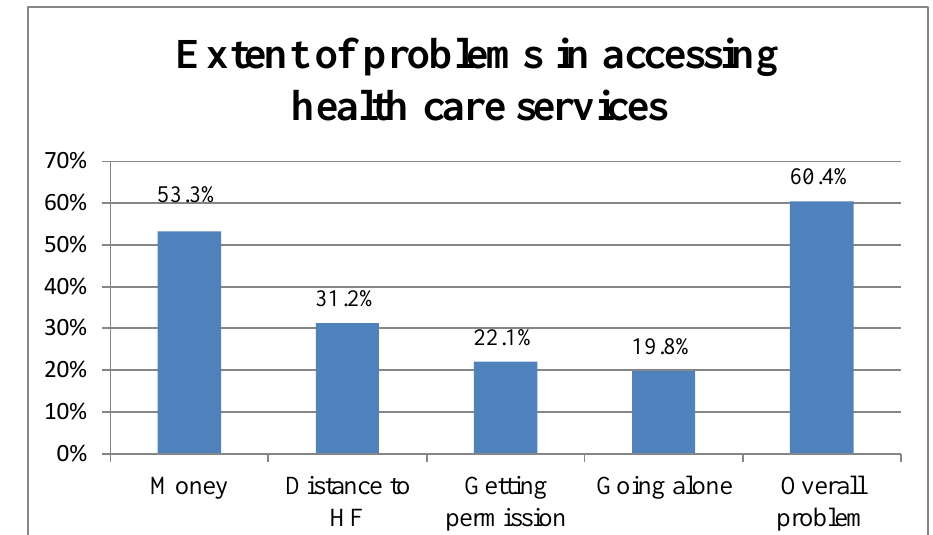
Figure 1. Extent of problems in accessing healthcare services among women in Benin: Evidence from 2017/2018 Benin Demographic and Health Survey (DHS).